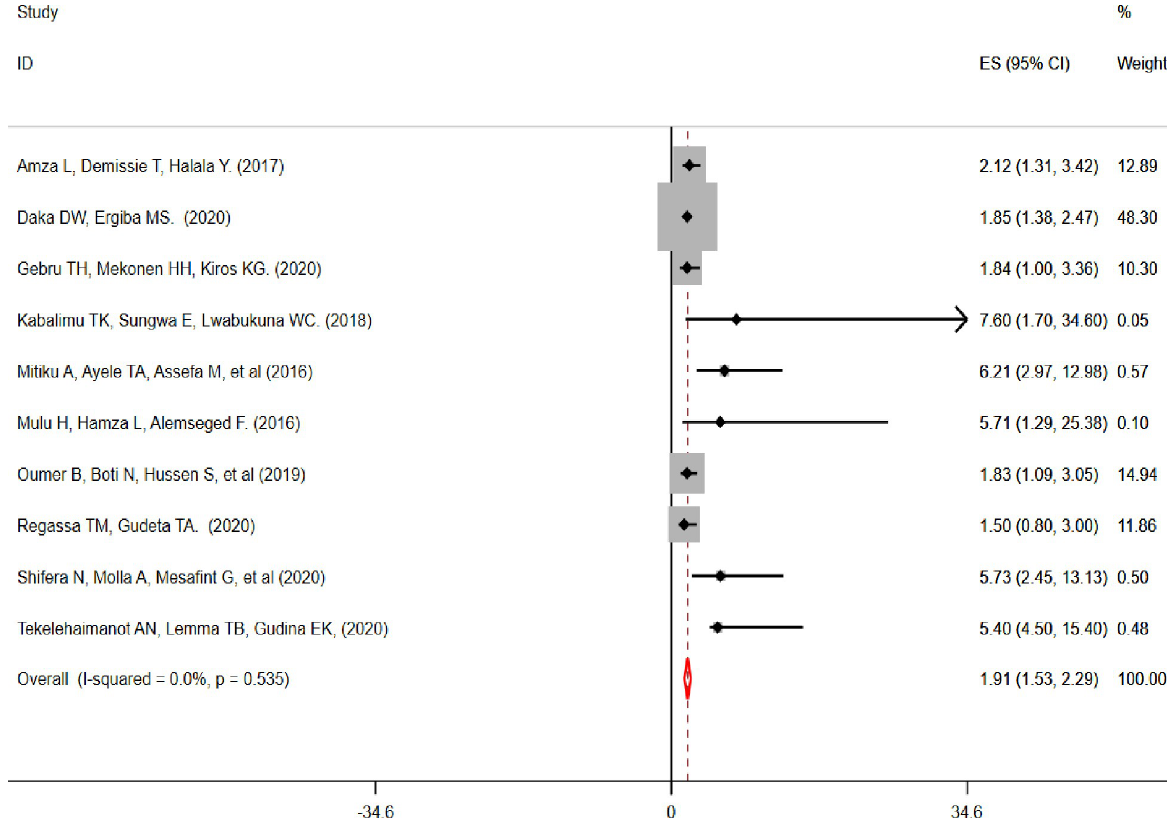
Fig 5. Pooled effect of “CD4 count” on undernutrition among adult PLWHIV in sub-Saharan Africa, 2021.